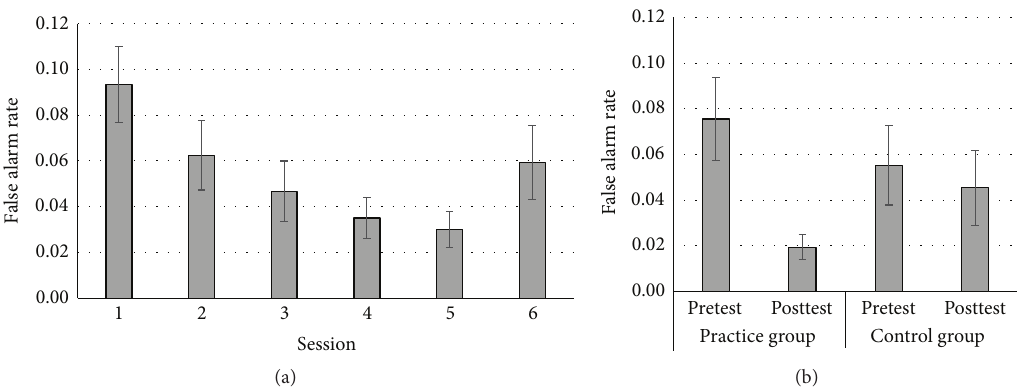
Figure 3: Practice effect (a) and transfer effect (b) of the Go-No Go task. Practice effect refers to performance improvement (i.e., reduced false alarm rate) across six practice sessions. Transfer effect was indexed by the performance improvement from pretest to posttest in the practice group, but not the control group. Error bars represent the standard